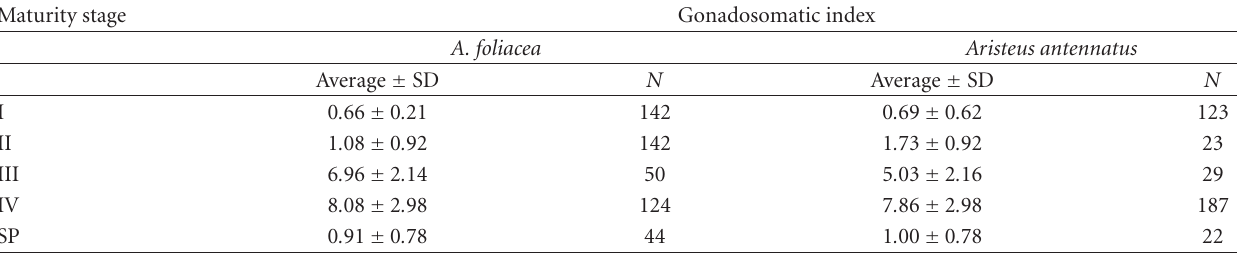
Table 3: Female average gonadosomatic index ( ± SD) of A. foliacea and Aristeus antennatus according to the ovarian maturity stage.